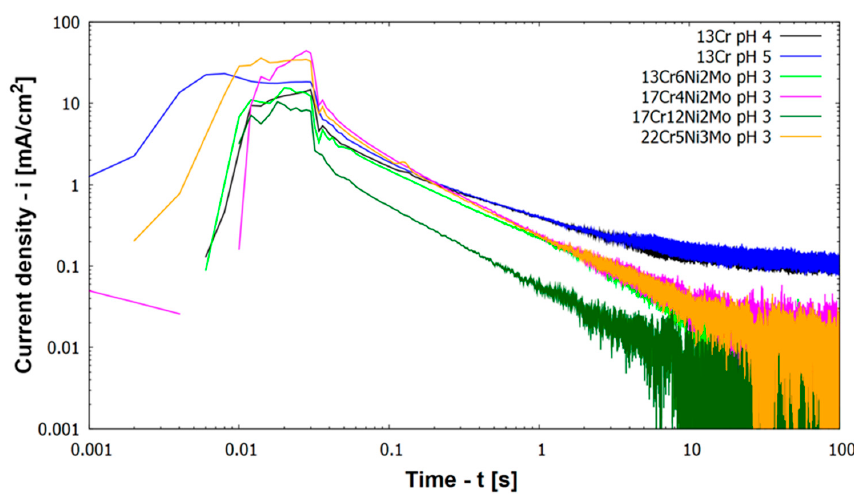
Figure 4. Current density vs. time during scratching and repassivation of investigated materials in 30,000 ppm Cl – at 30 °C (scratch ended after 0.03 s).